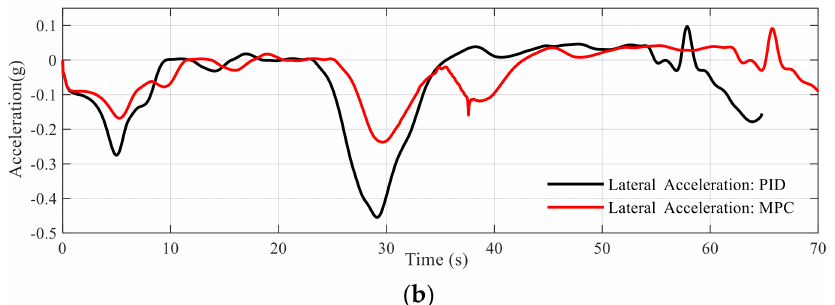
Figure 8. Acceleration comparison of two controllers, PID and MPC: ( a ) Longitudinal acceleration of two controllers; ( b )Lateral acceleration of two controllers.